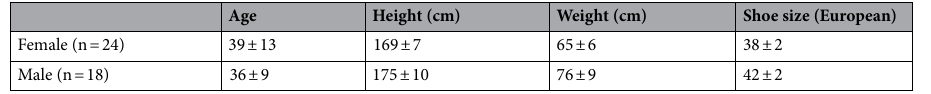
Table 1. Descriptive statistics for the participants. Mean and standard deviations values for age, height, weight, and shoe